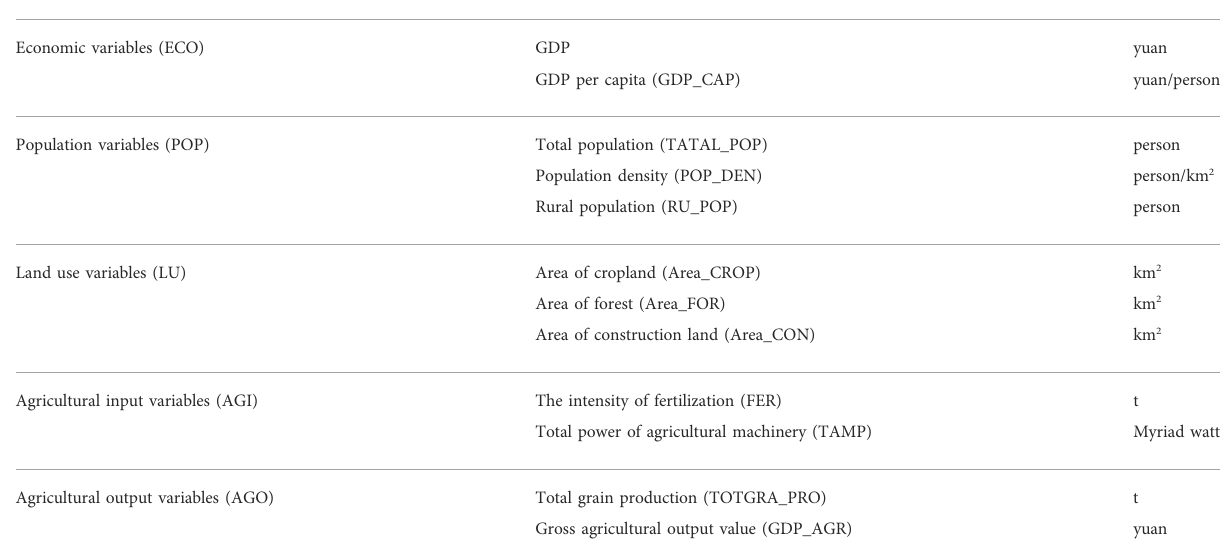
TABLE 1 The details of socio-economic factors